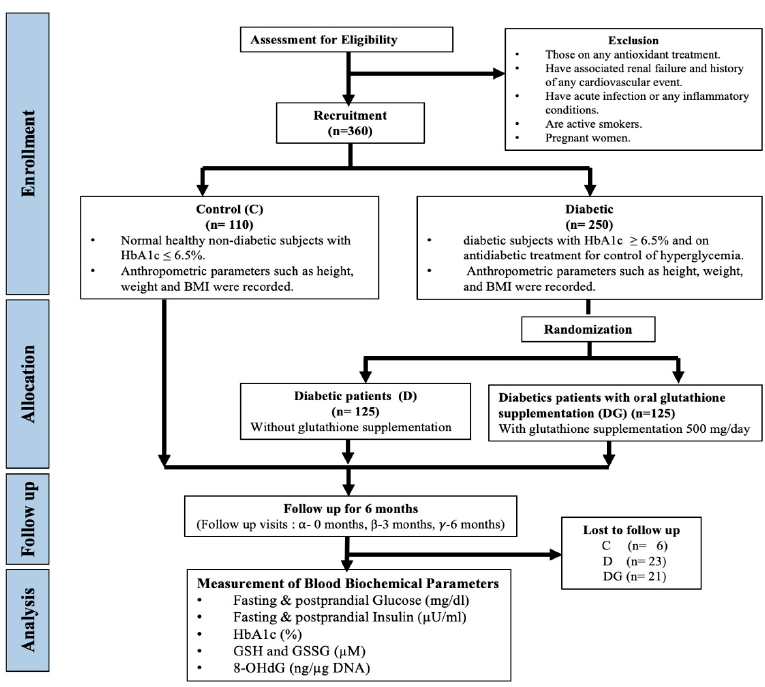
Figure 1. Flowchart for study design.